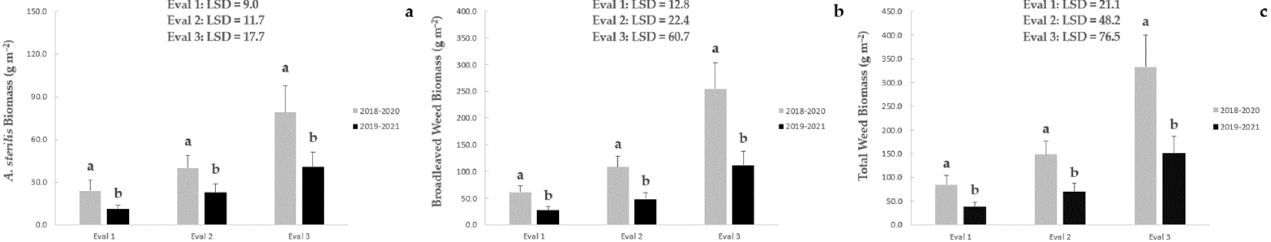
Figure 1. Cover crop biomass production (kg ha − 1 ) in 2018 and 2019 before the 2018–2020 and 2019–2021 sulla growing cycles, respectively, averaged ( a ) across all species and ( b ) per species. Different lowercase letters indicate significant differences. Vertical bars indicate standard errors.